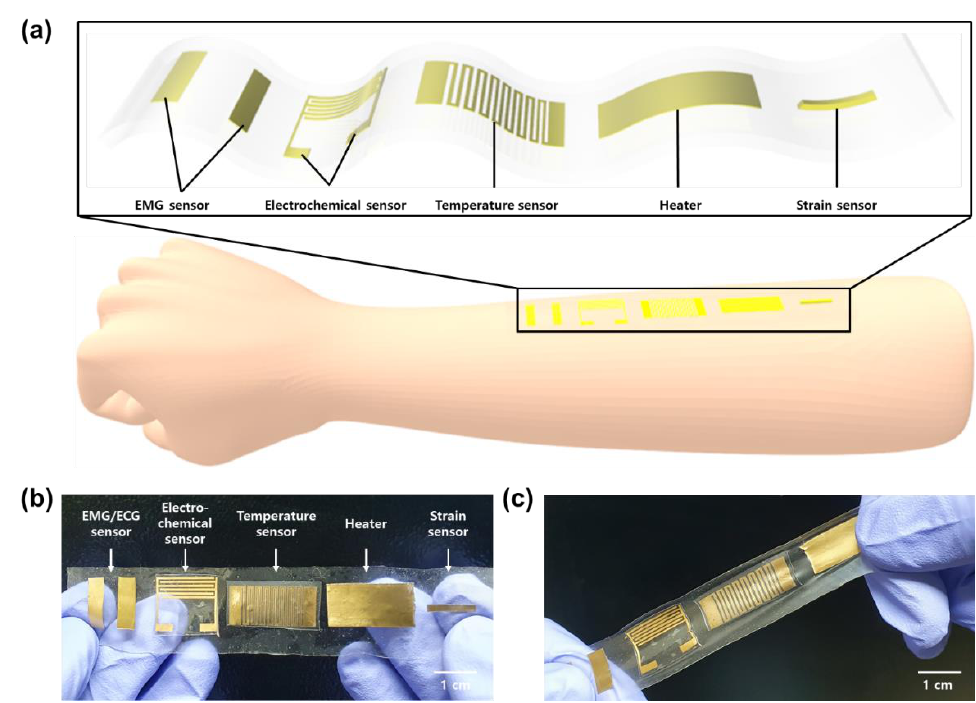
Figure 1. ( a ) Overall schematic of the soft bio-integrated multifunctional devices in intrinsically stretchable conducting nanomembrane electrodes. ( b ) Photograph of the device before being stretched. ( c ) Photograph of the device after being stretched.